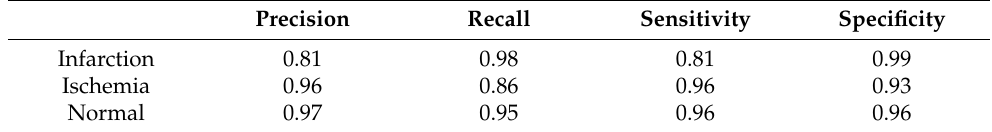
Table 3. Presentation of values of efficient metrics of the VGG-16 model for each class. Precision Recall Sensitivity Specificity Infarction 0.81 0.98 0.81 0.99 Ischemia 0.96 0.86 0.96 0.93 Normal 0.97 0.95 0.96 0.96